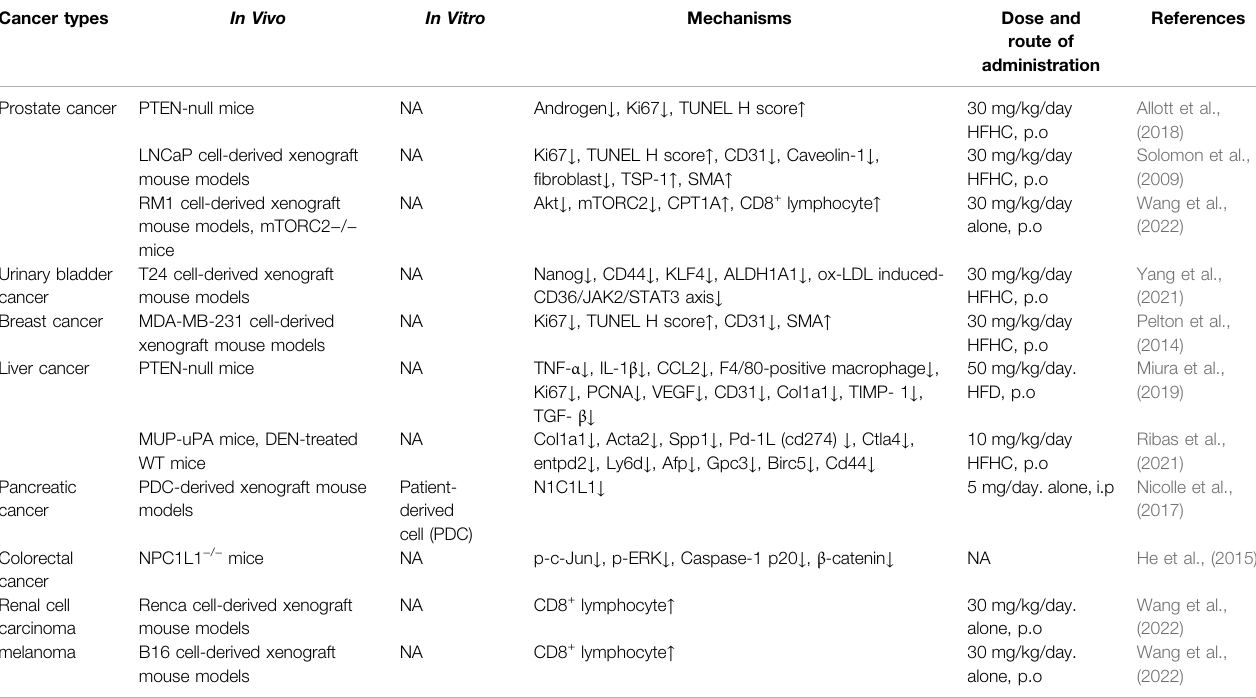
TABLE 1 | In vitro and in vivo evidence of ezetimibe against